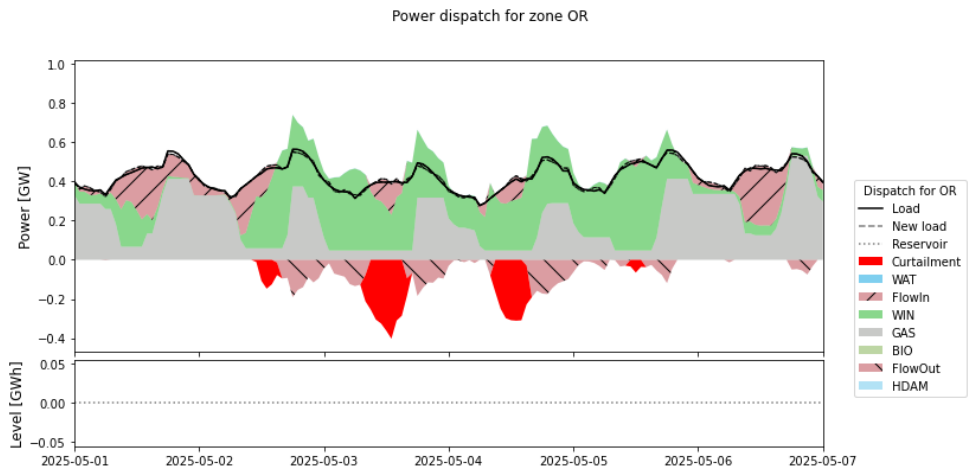
Figure 28. Moderate-Penetration Scenario 1(NH)—Oriental zone (1–7 May